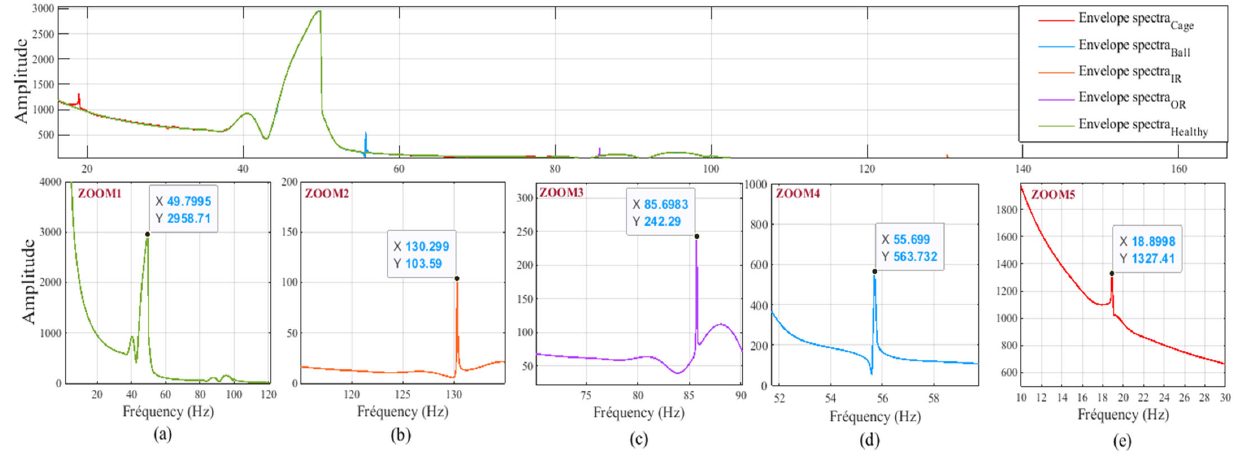
Figure 25. The current envelope spectra corresponding to the BDs for the nominal speed (1440 Rpm) ( top ). Zoom showing each spectrum: ( a ) Healthy state, ( b ) IR defect, ( c ) OR defect, ( d ) Ball defect, ( e ) cage defect.